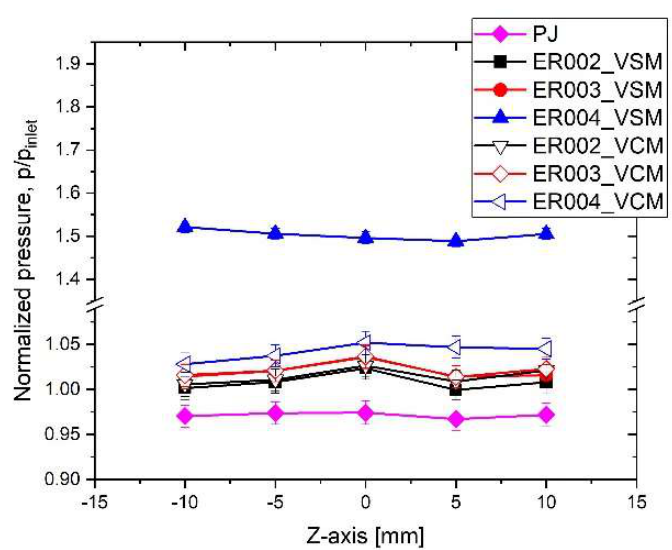
Figure 13. Span-wise pressure distribution comparison: VCM—vent circle mixer, VSM—vent slot mixer, ER—equivalence ratio.